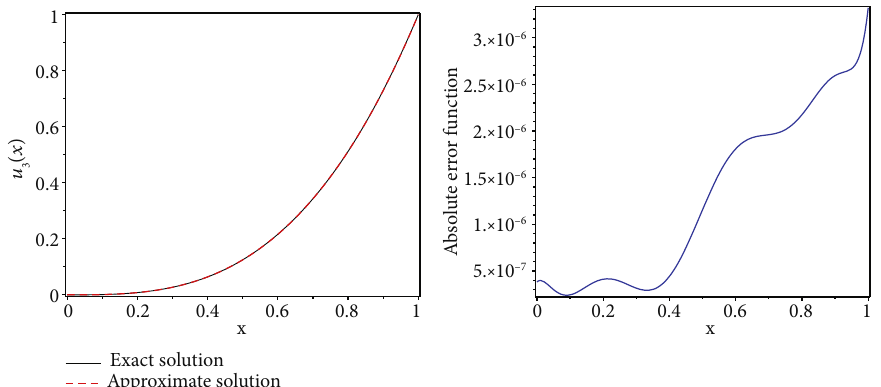
ð x Þ for N = 9 and ν 3